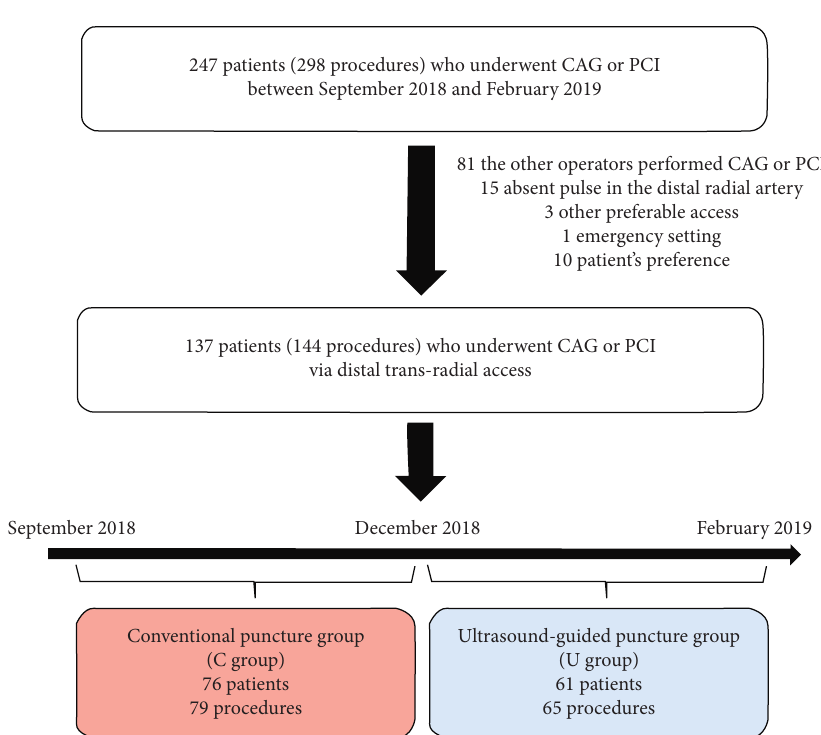
Figure 1: Study flowchart. CAG: coronary angiography; PCI: percutaneous coronary intervention.